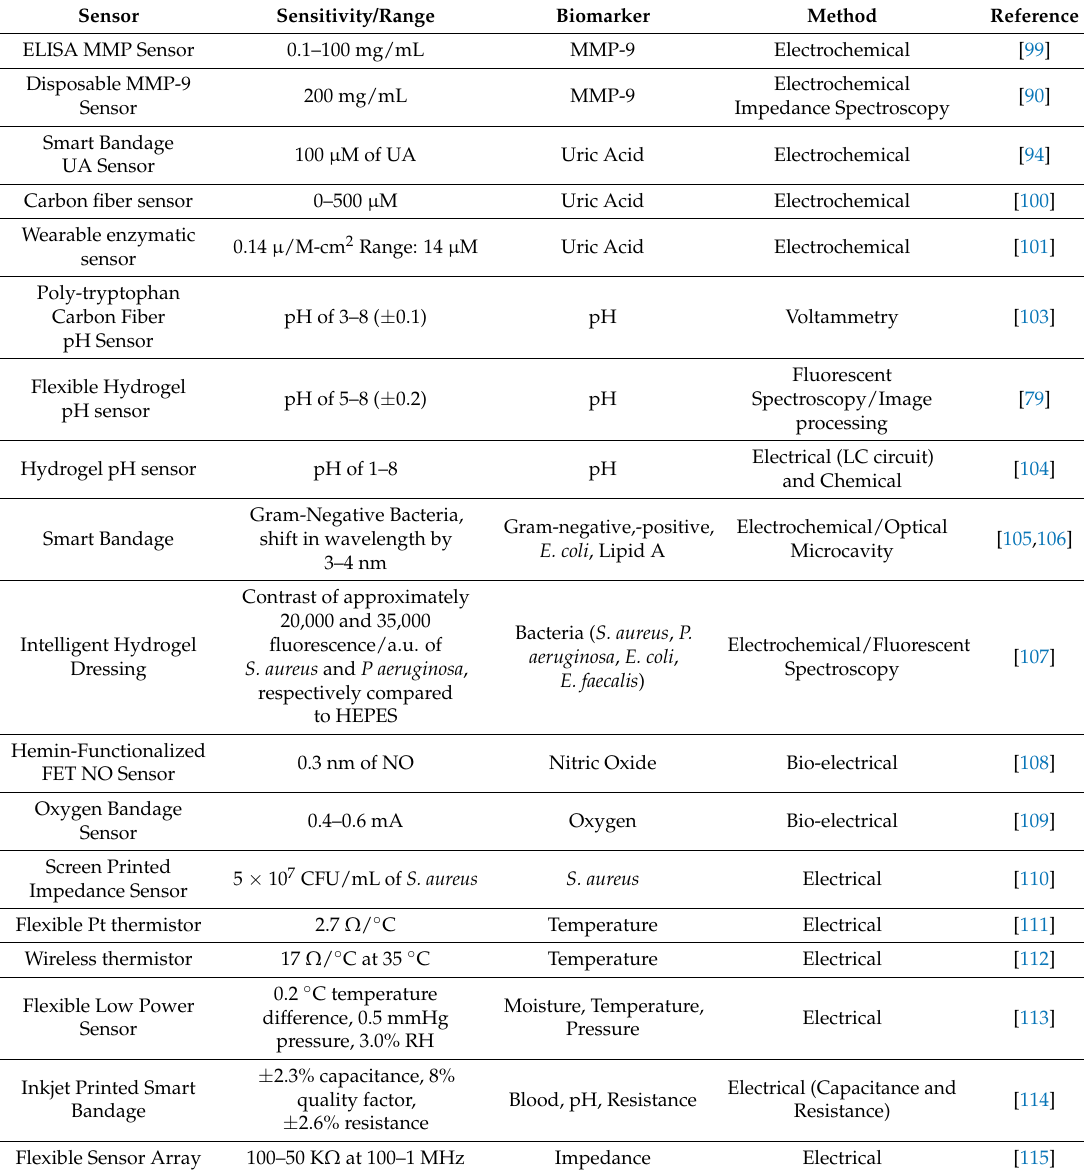
Table 4. Sensor Used to Detect Biomarkers in Chronic